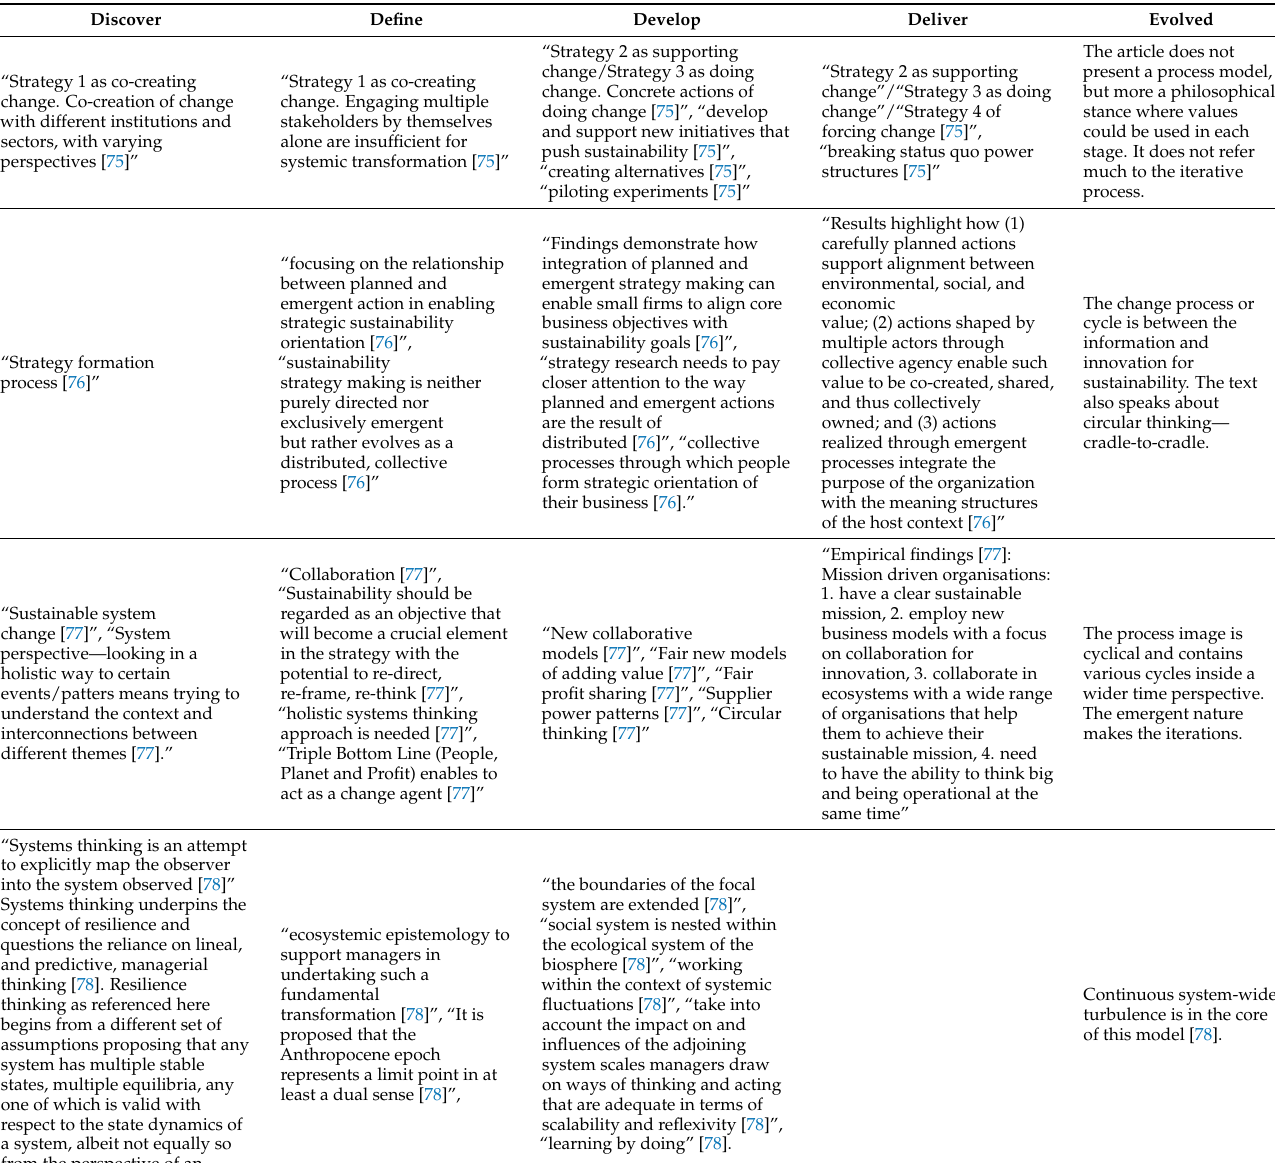
Table 3. Extraction of SLR results and mirroring to Evolved Double Diamond